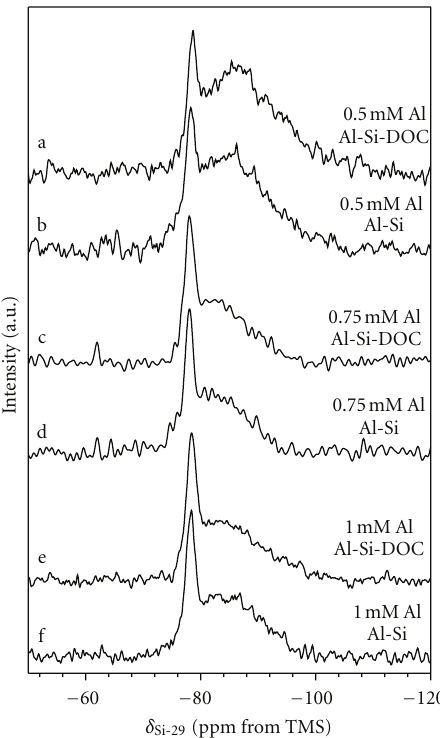
Figure 5: 29 Si SP/MAS NMR spectra of precipitates from solutions with 0.5 mM Si and (a-b) 0.5mM Al; (c-d) 0.75 mM Al; (e-f) 1.0mM Al; with and without 6 mg/L DOC as indicated. All spectra were taken under quantitative conditions with a 180 s relaxation delay and 10kHz spinning